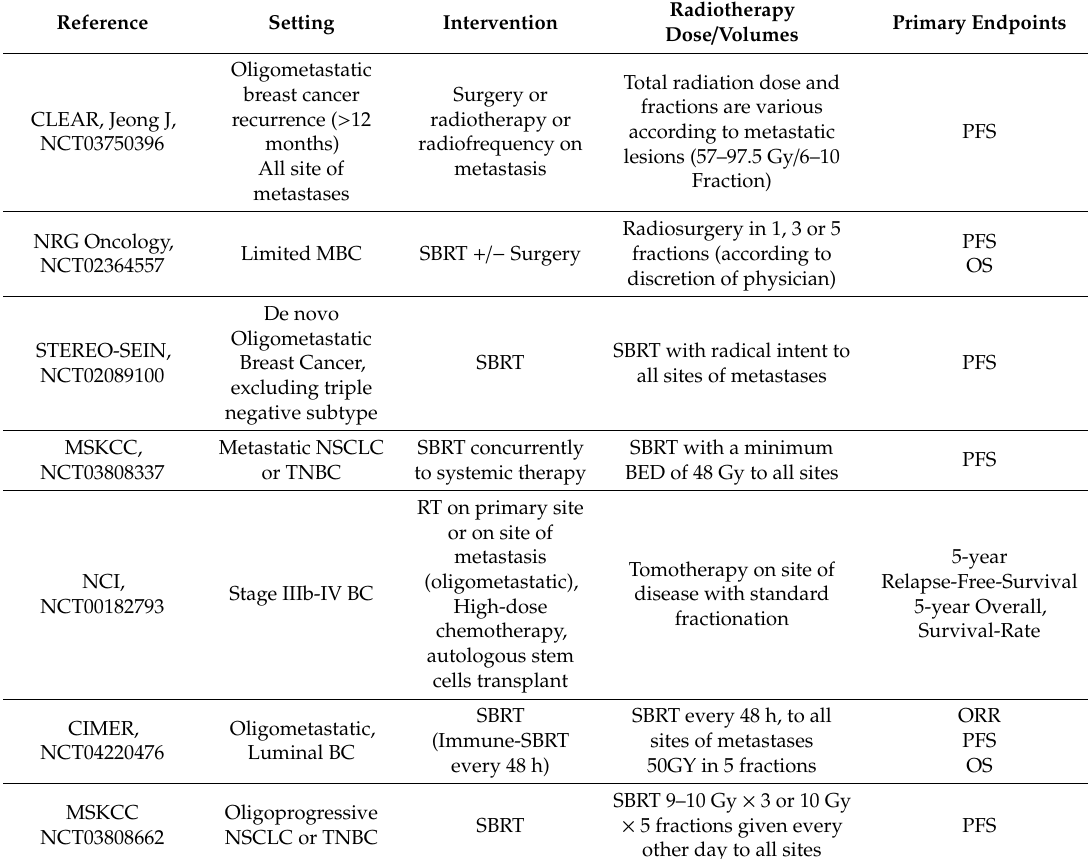
Table 2. Ongoing trials of oligometastatic and oligoprogressive breast cancer